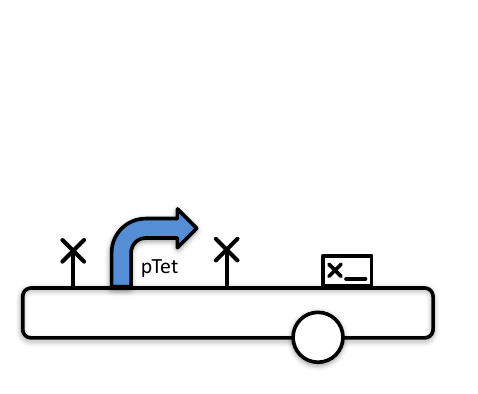
Figure 31: Promoter pTet stored in a circular plasmid, flanked by restriction sites with unspecified cut structure. In addition, the plasmid has been bar-coded with a signature and has its origin of replication marked.